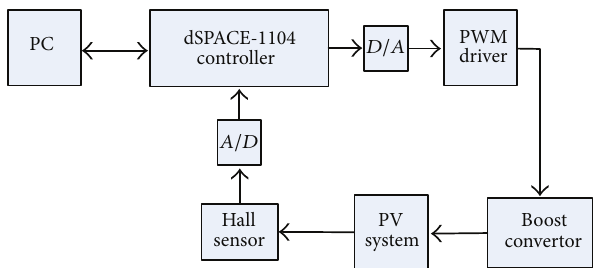
Figure 14: Hardware architecture used to evaluate real-world performance of SMESC